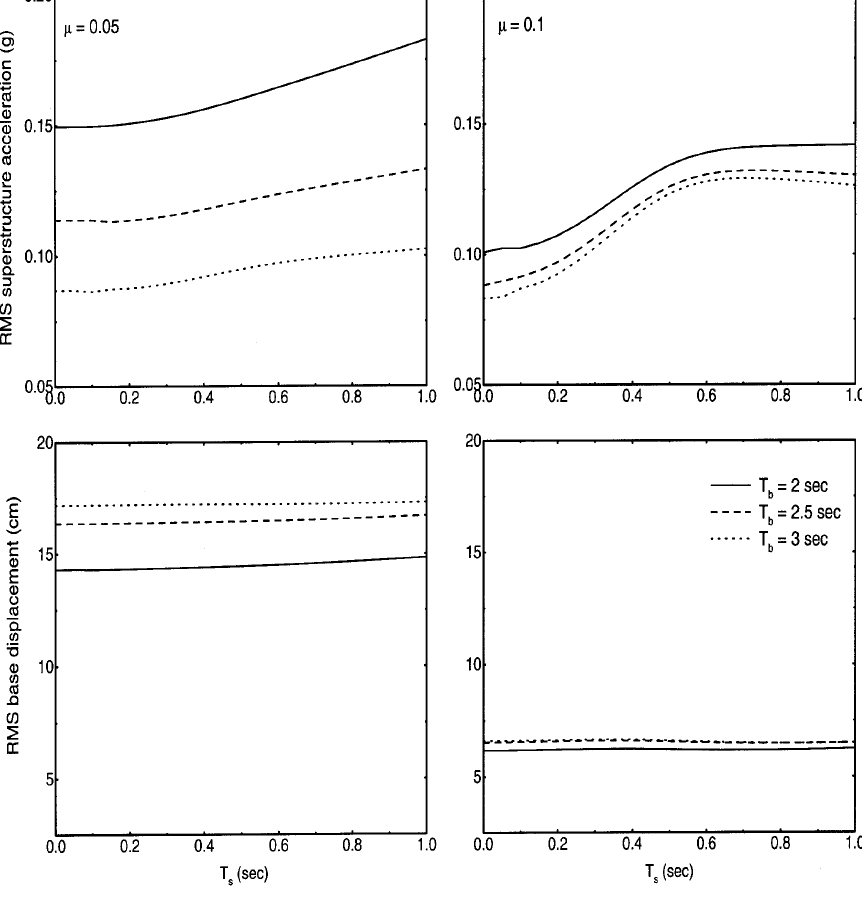
Fig. 9. Effects of the superstructure flexibility on the peak response of structure isolated by the FPS